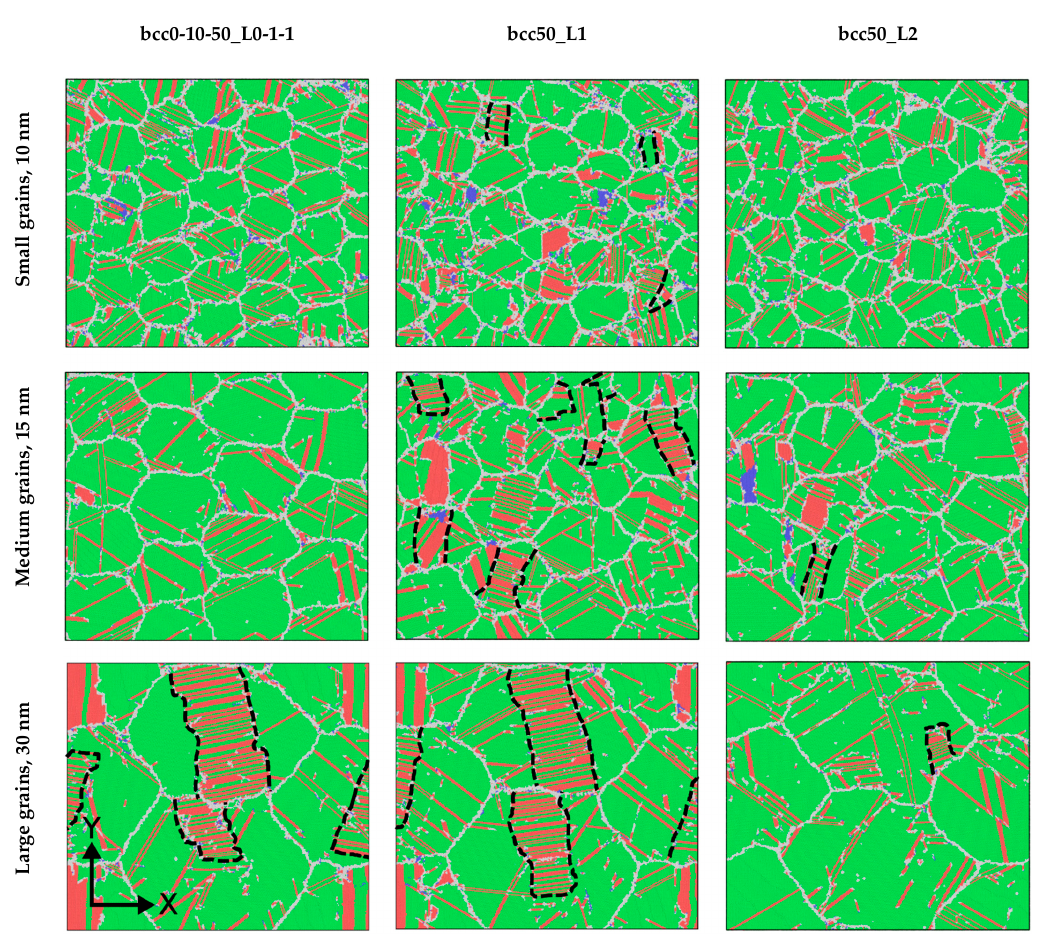
Figure 22. XY cross-sections of different layers of samples with differently distributed initial bcc phases stretched to 20.00%. Atoms with bcc, hcp, fcc, and uncertain nearest neighbor symmetry are shown in blue, red, green, and gray. Fragment boundaries are marked off by dashed lines.